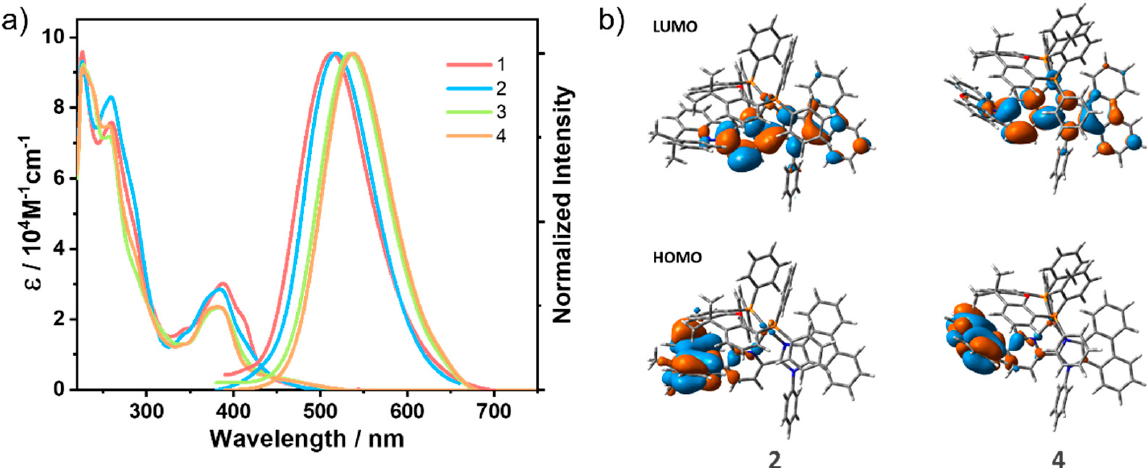
Figure 3. ( a ) UV-vis absorption and emission spectra of 1 – 4 in CH 2 Cl 2 solution (1 × 10 − 5 M) at 298 K; ( b ) Frontier molecular orbitals for 2 and 4 at their optimized ground state geometries.